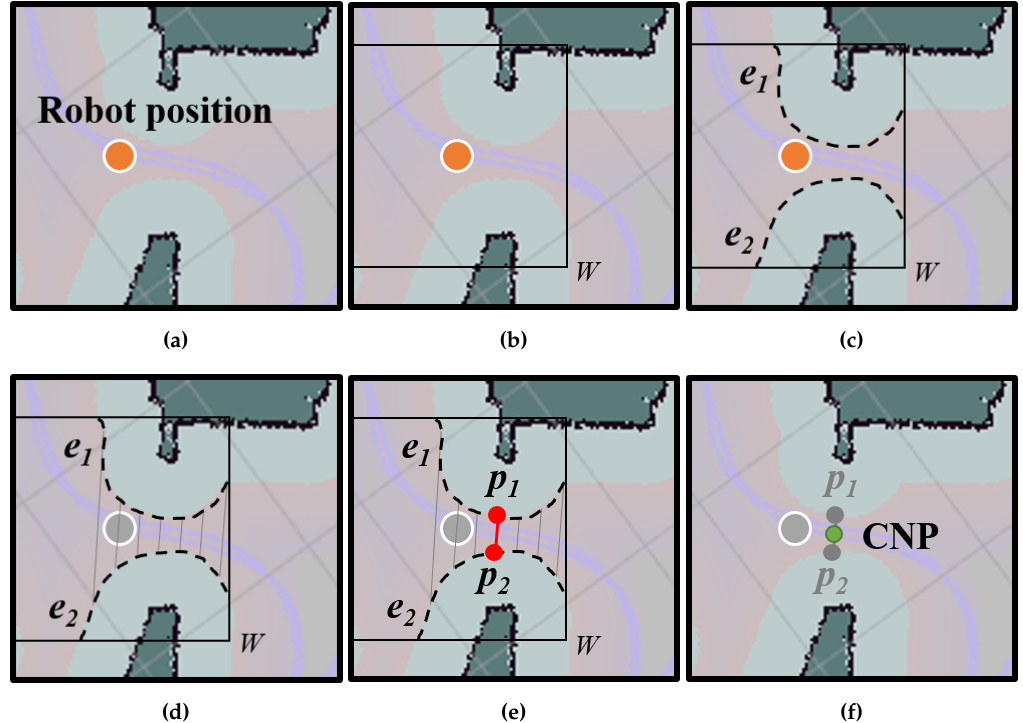
Figure 2. Detection of a critical navigation point (CNP) in a cost-map. In this case, the pink areas correspond to navigable space. ( a ) From the robot position at a failure zone (in orange), ( b , c ) we detect cost edges within a window W around it. ( d ) All the distances between edges e 1 and e 2 are computed and ( e ) the points yielding the minimum distance are selected ( p 1 and p 2 ). ( f ) The CNP is finally placed at the